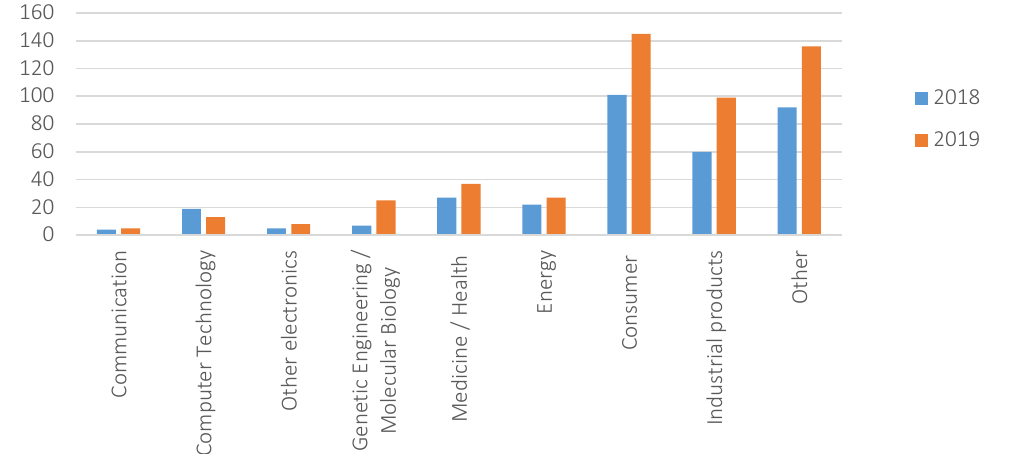
Figure 1. The number of profiles of business entities in the EEN system that are at certain stages of cooperation with entrepreneurs from Ukraine for 2018 – first half of 2019 Source: Developed by the authors based on the Enterprise Europe Network in Ukraine